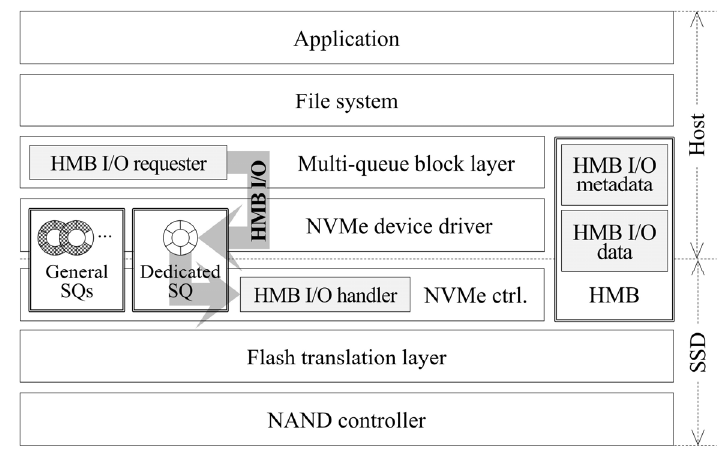
Figure 4. System architecture supporting HMB I/O.